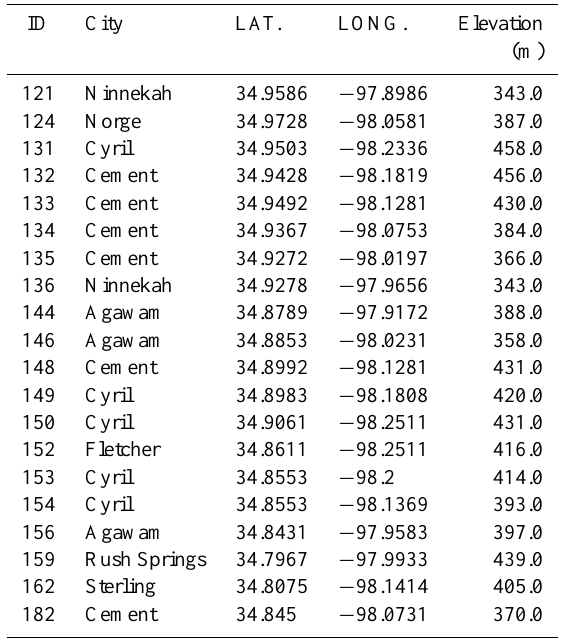
Table 2. List of the meteorological stations used in the simulations